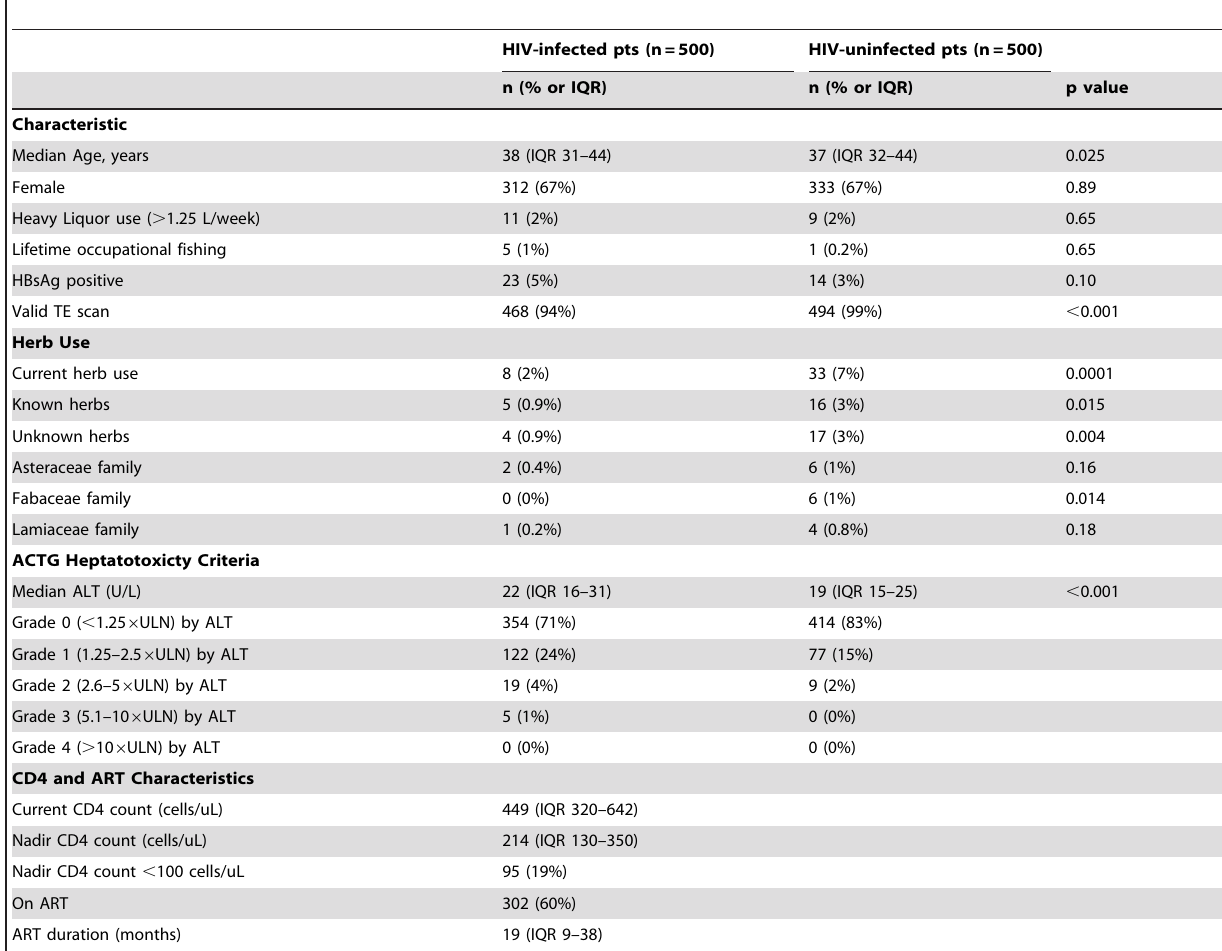
Table 1. Baseline characteristics of study